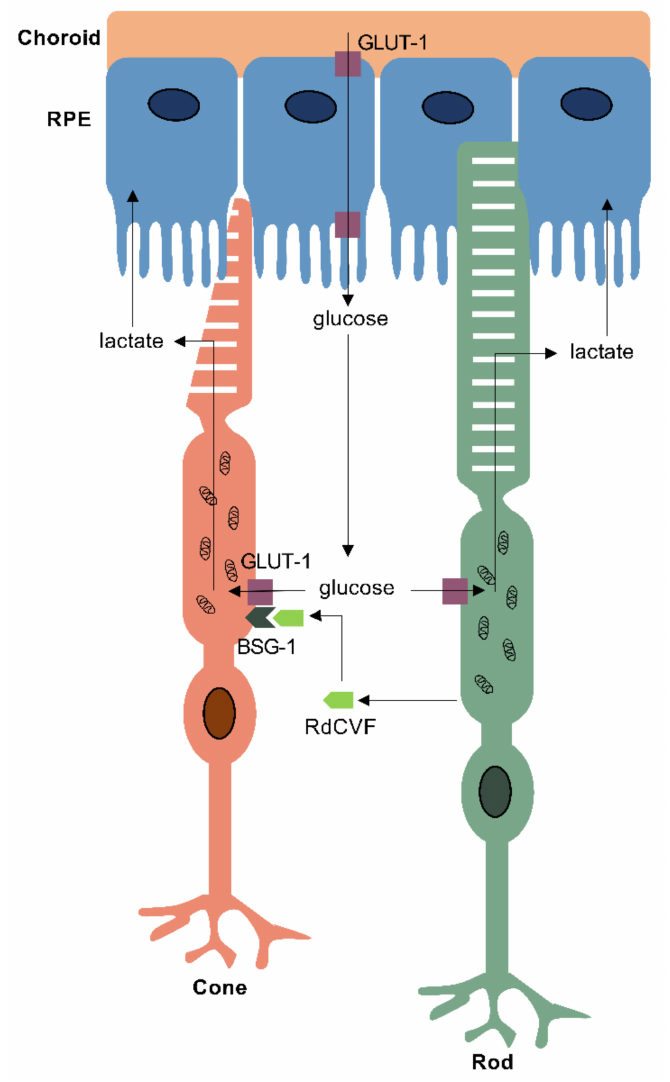
Figure 3. The metabolic ecosystem in the outer retina. The distinct metabolic pathways operating in rod and cone photoreceptors and retinal pigmented epithelium (RPE) cells work together to establish a precisely balanced metabolic ecosystem. The RPE mediates the transepithelial transport of glucose from the choroidal vasculature to rod and cone photoreceptors via GLUT-1 transporters, to fuel aerobic glycolysis in photoreceptor outer segments. Rods release rod-derived cone viability factor (RdCVF) which enhances glucose uptake into cones, by forming a complex with its transmembrane receptor, basigin-1 (BSG-1) and GLUT-1. Both rods and cones produce lactate as an end-product of their metabolism, which is subsequently secreted and taken up by RPE cells, which utilise it as their primary metabolic substrate. Thus, the precise metabolic relationships between the three cell types are crucial for sustaining the functions of the outer retina, and their imbalance may result in